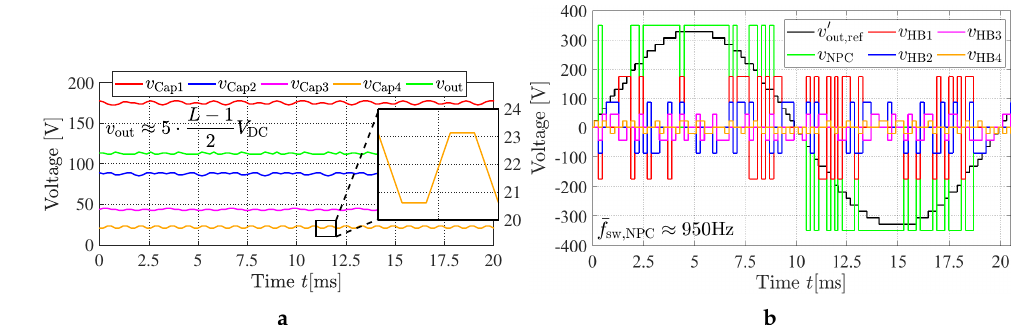
Figure 6. Switching-state sequence generation: ( a ) simulated capacitor voltage oscillations using the suggested one-time-step MPC approach for one discrete output voltage level and ( b ) generated switching-state sequence for one electrical